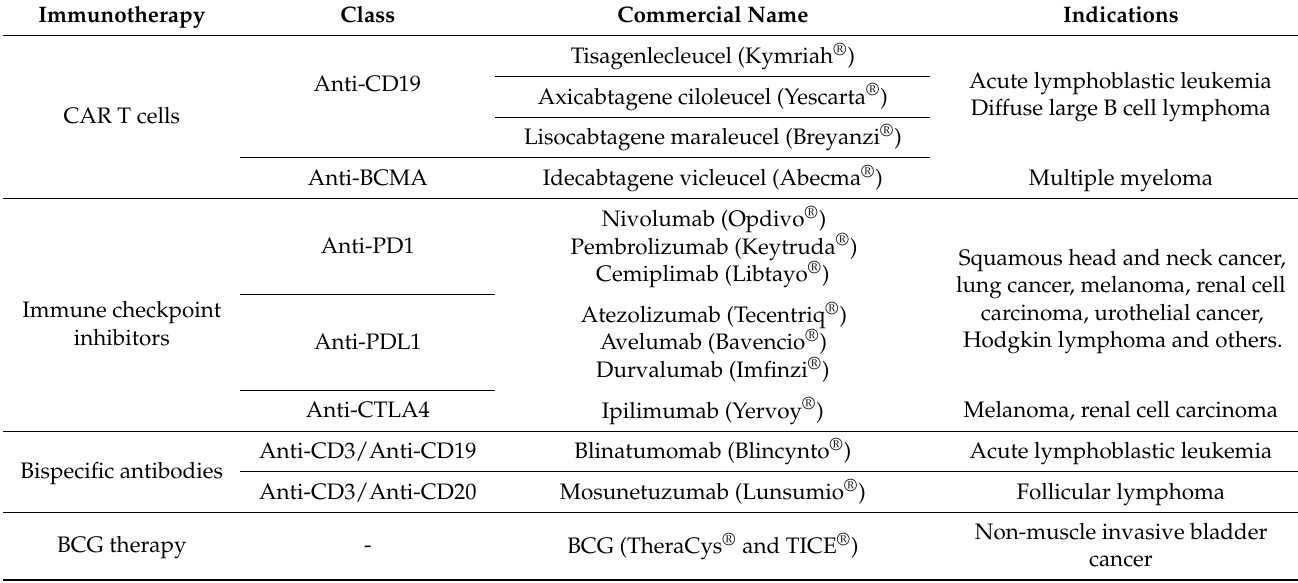
Table 1. List of approved cancer immunotherapies and their indications.